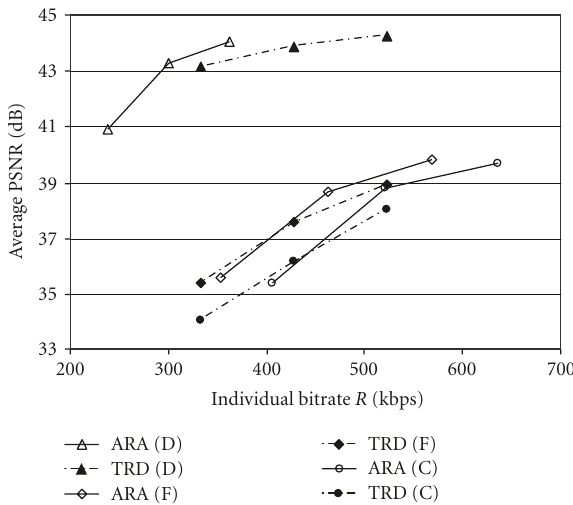
Figure 6: Individual PSNR as a function of the total bitrate, for the Carphone (C), Foreman (F), and Mother-Dauther (D) sequences, with M = 4.